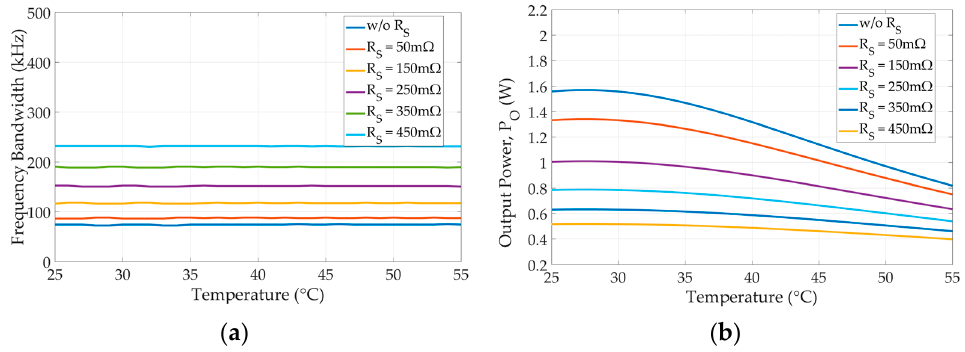
Figure 9. ( a ) Bandwidth and ( b ) output power for different series resistance values.